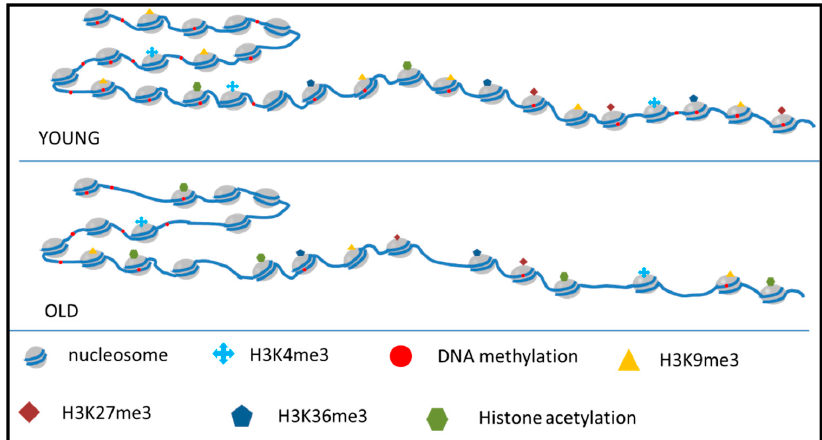
Figure 2. Histone modification changes during aging. During aging, DNA shows hypomethylation. A global loss of histone protein makes the chromatin structure looser. Histone methylation and acetylation show dynamic changes with age. These changes work together to contribute to the aging